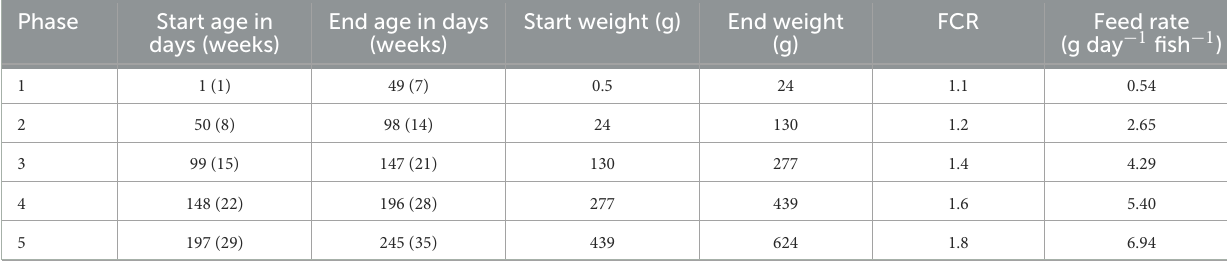
TABLE 3 Phased fish production based on desired daily N production rate. Phase